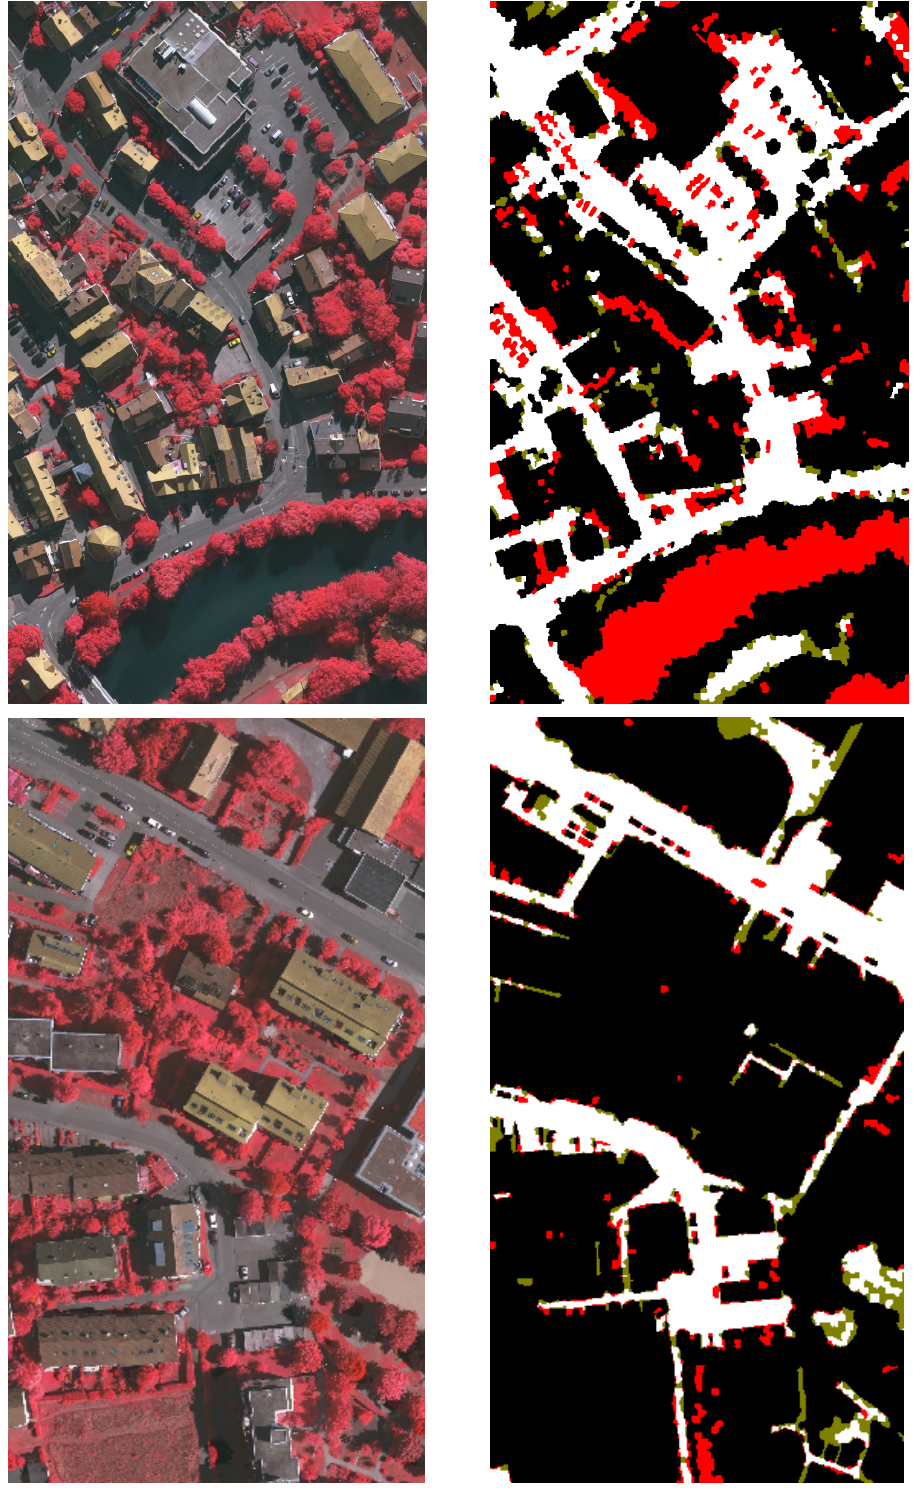
Figure 4: Results of classification: average patch, Random Forests classifier (below), challenging patch, Logistic Regression (above). On the left, the orthophoto and on the right, the classification result (white and black: true positives and negatives, dark-green and red: false positives and negatives,